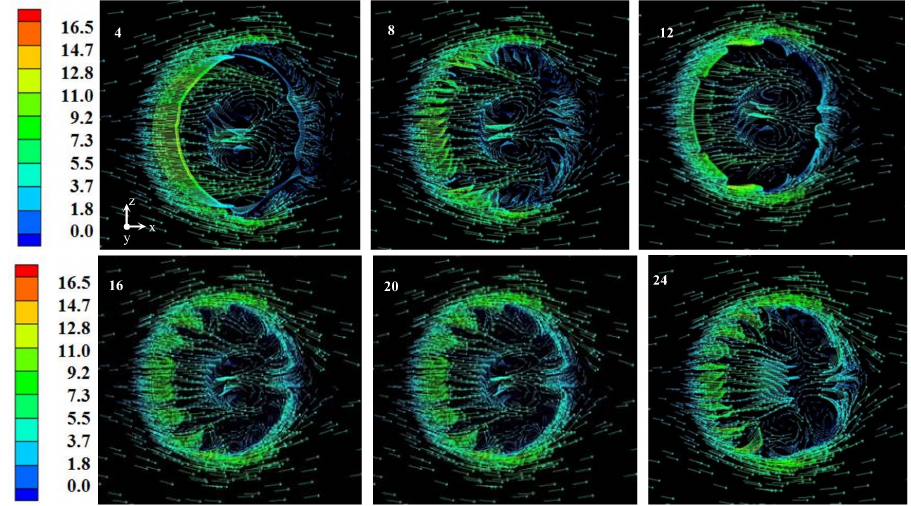
Figure 15. Velocity vectors (unit: m · s − 1 ) of the air at the tower inlet with various number of wind deflectors under the crosswind speed of 5 m/s.